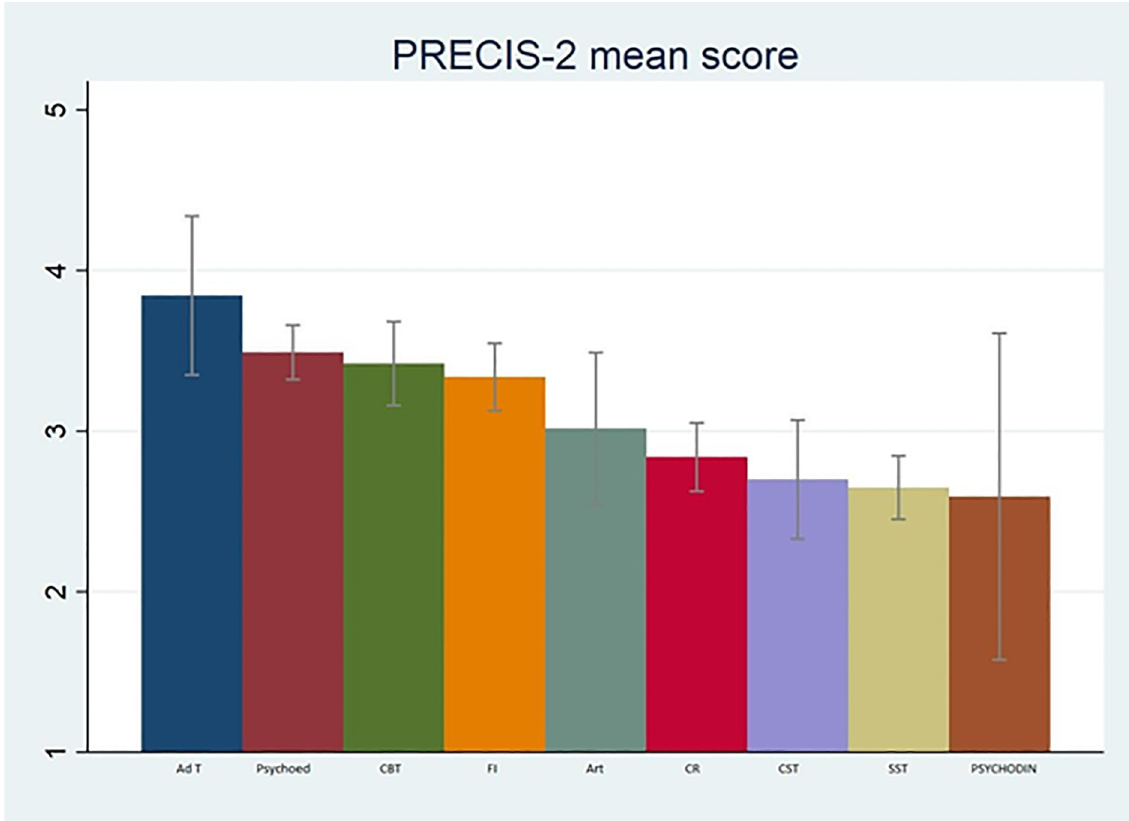
Fig 3. Mean precis score by intervention (p < 0.001). Ad T = Adherence Therapy (N = 4); PSYCHOED = psychoeducation (N = 17); CBT = Cognitive Behavioural Therapy (N = 33); FI = Family Intervention (N = 31); ART = Art Therapies (N = 7); CR = Cognitive Remediation (N = 22); CST = Counselling and Supportive Therapy (N = 7), SST = Social Skills Training (N = 18); PSYCHODINAM = Psychodynamic and Psychoanalytic Therapies (N =